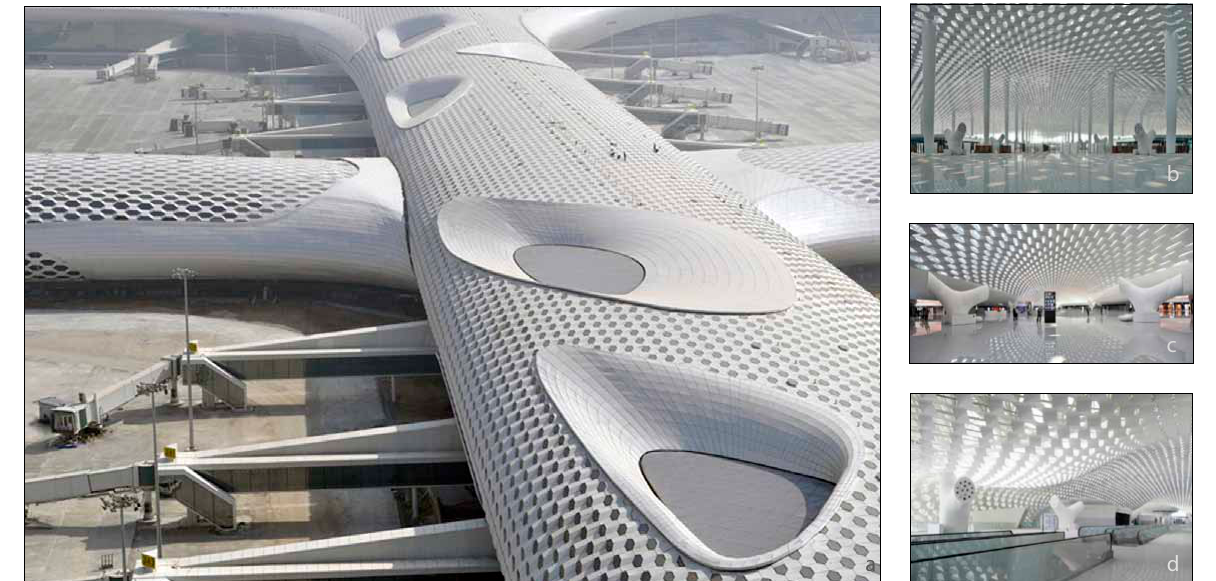
fig. 8. Shenzhen Bao’an airport, Terminal